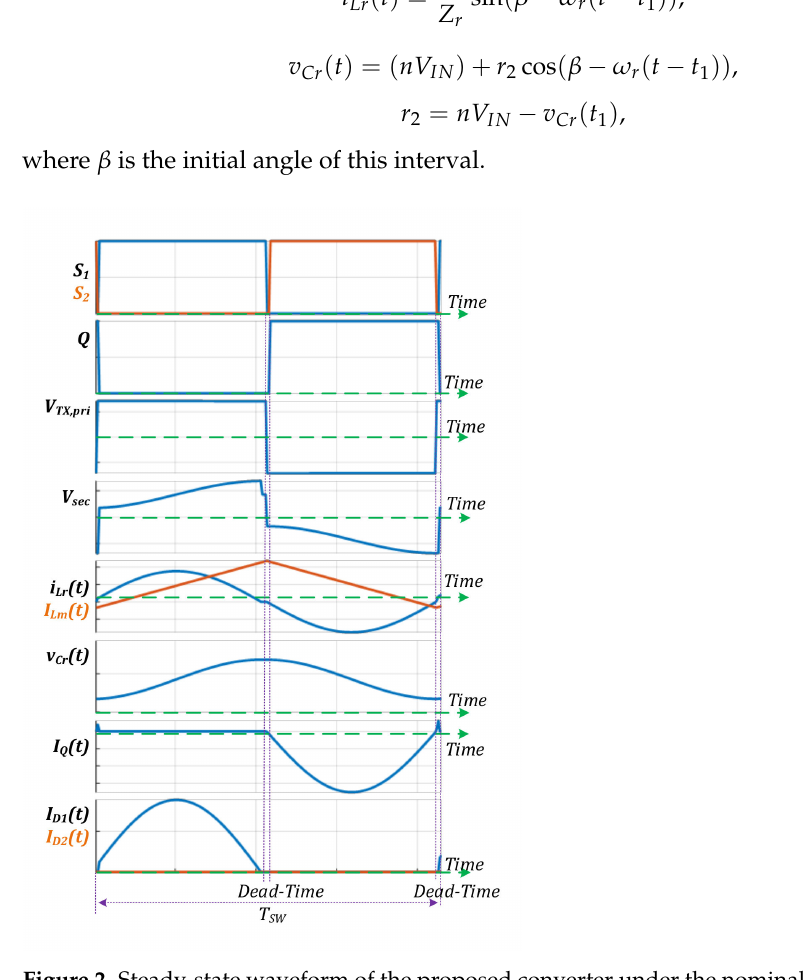
Figure 2. Steady-state waveform of the proposed converter under the nominal input voltage ( pure - SRC conditions).